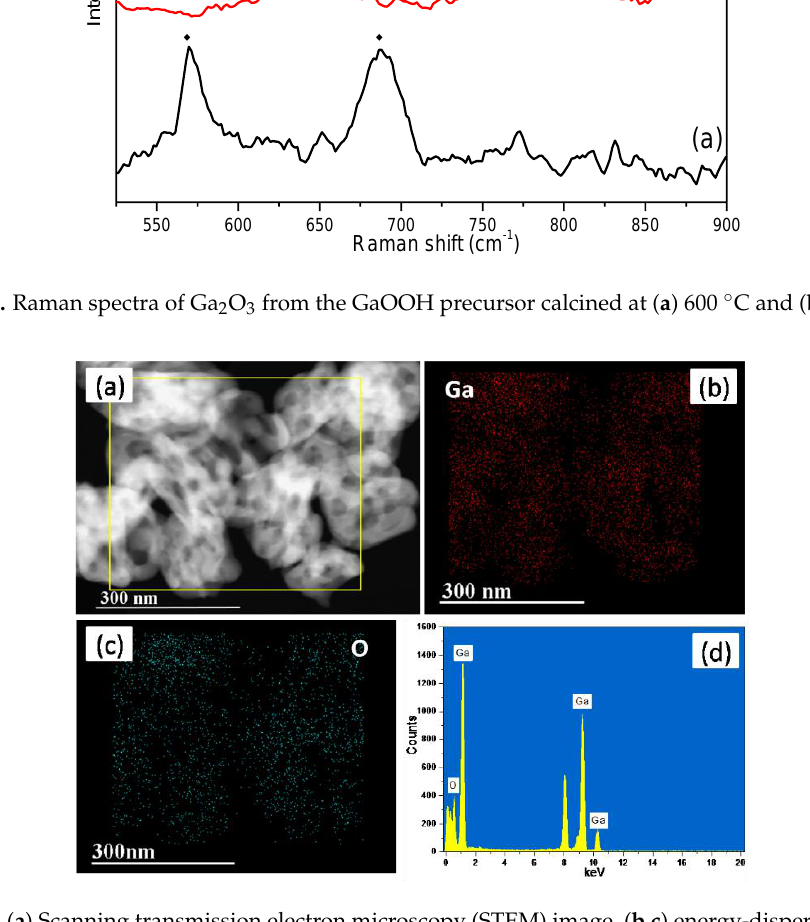
Figure 3. Transmission electron microscopy (TEM) and high-resolution transmission electron microscopy (HRTEM) images of ( a , b ) GaOOH and ( c , d ) Ga 2 O 3 . The morphology and microstructure of GaOOH precursor and its calcined product Ga 2 O 3 were investigated by TEM and SEM. As shown in Figure 3a,b, the GaOOH precursor presents monodisperse nanoplate-like structure. Compared with GaOOH (Figure 3a,b), Ga 2 O 3 nanoparticles (Figure 3c) present porous hollow structures. Moreover, the clearly resolved lattice fringes with d